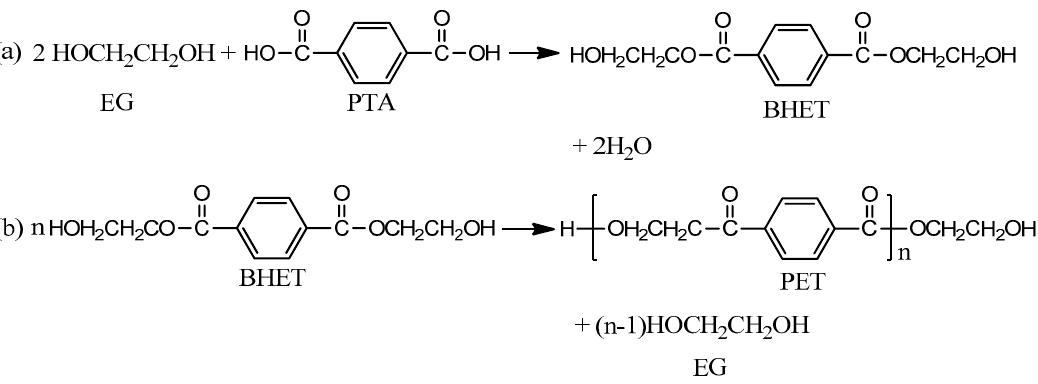
Table 1. Samples and its corresponding numbers.